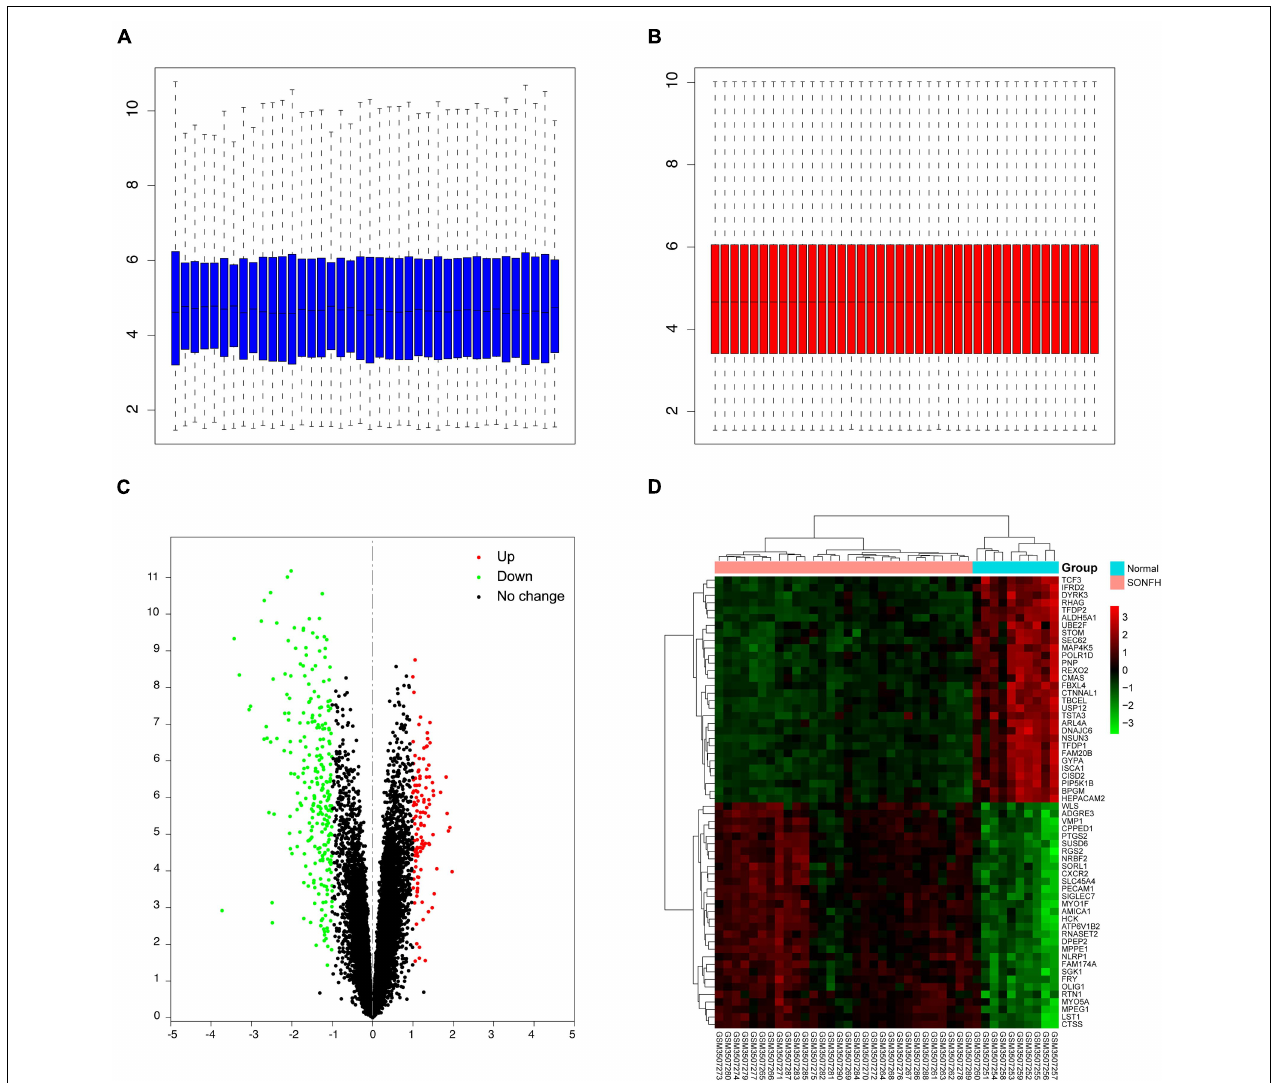
FIGURE 2 | Data preprocessing and DEGs screening. (A,B) Box plots of the expression profiles: Before normalization (blue) and after normalization (red); (C) volcano map of DEGs; red represents up-regulated differential genes, black represents no significant difference genes, and green represents down-regulated differential genes; (D) heat map of top 30 up-regulated and down-regulated genes from all samples; red indicates higher gene expression and green indicates lower gene